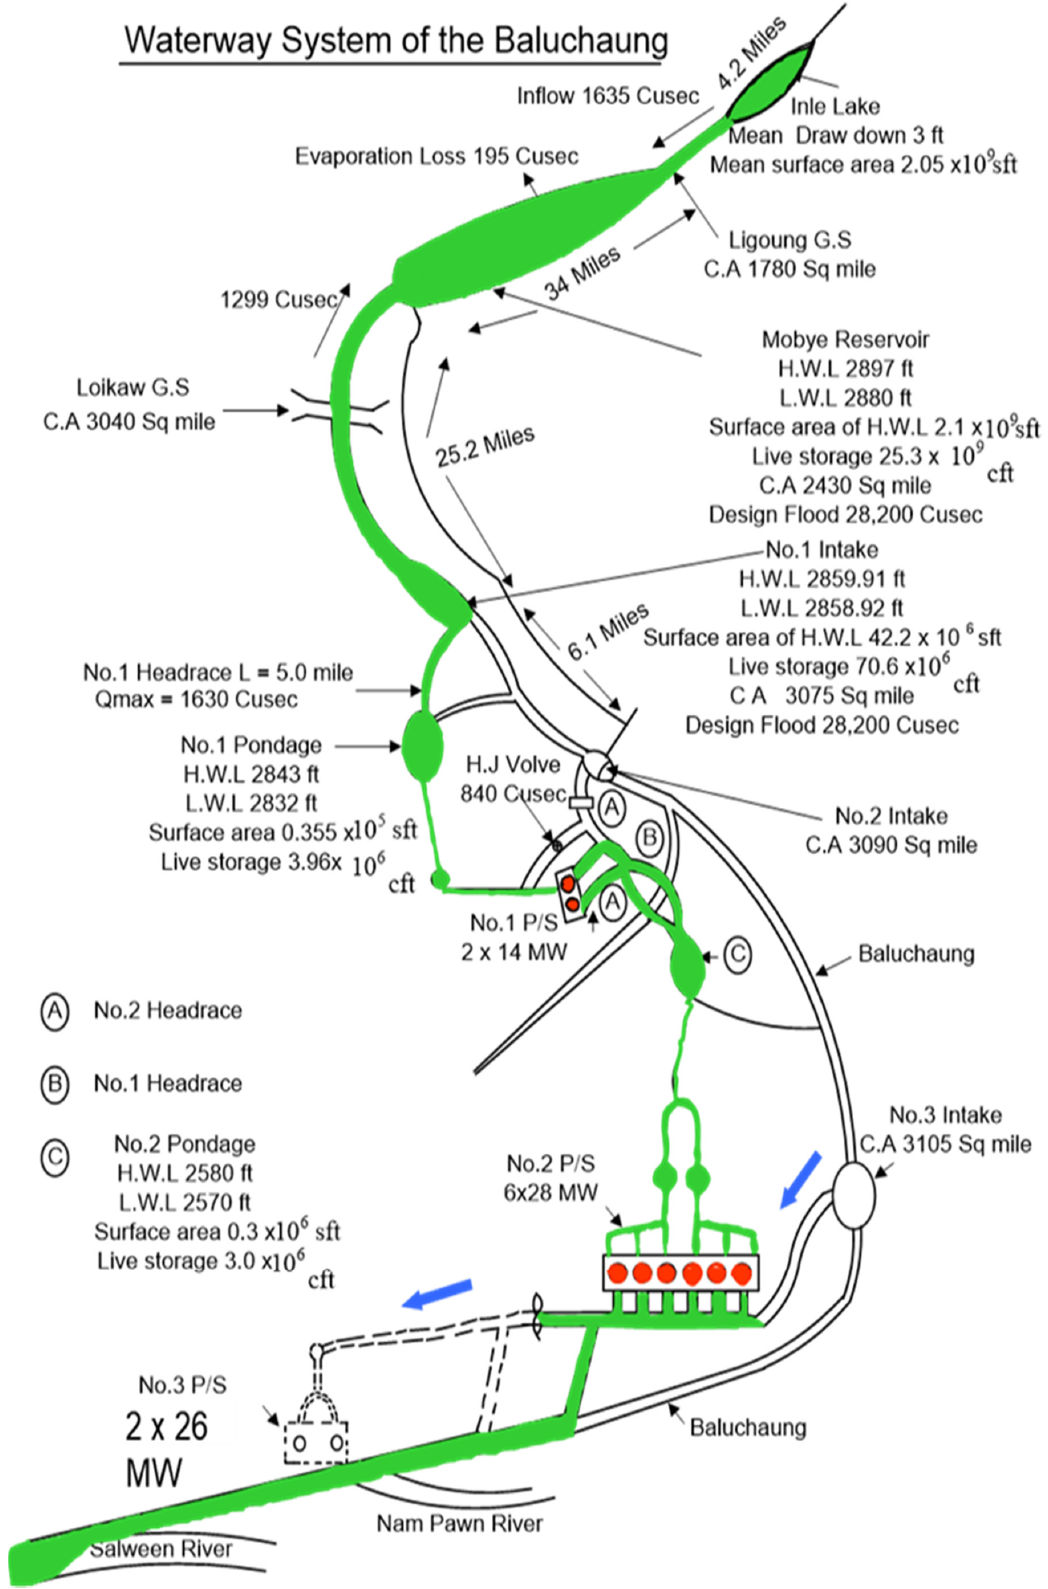
Figure 1. Waterway System of Baluchaung II hydropower station.